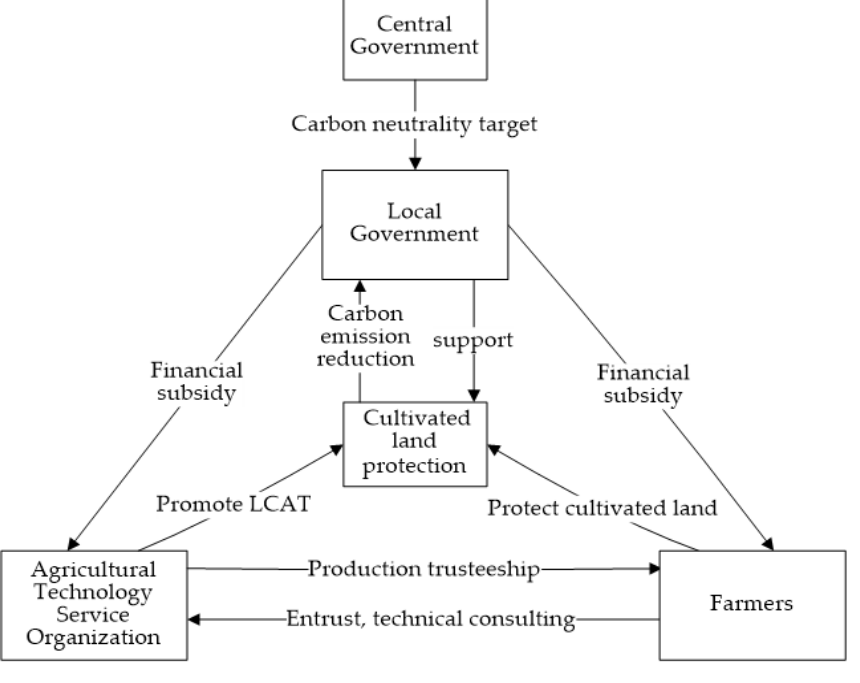
Figure 1. Stakeholders’ relationship diagram.